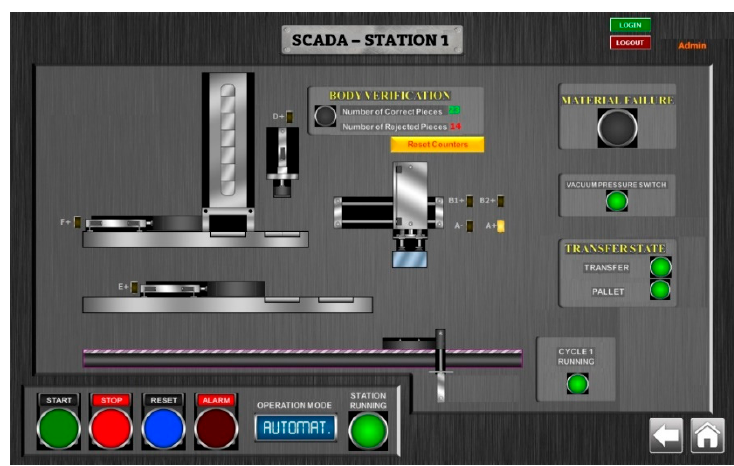
Figure 19. Monitoring screen of station 1.